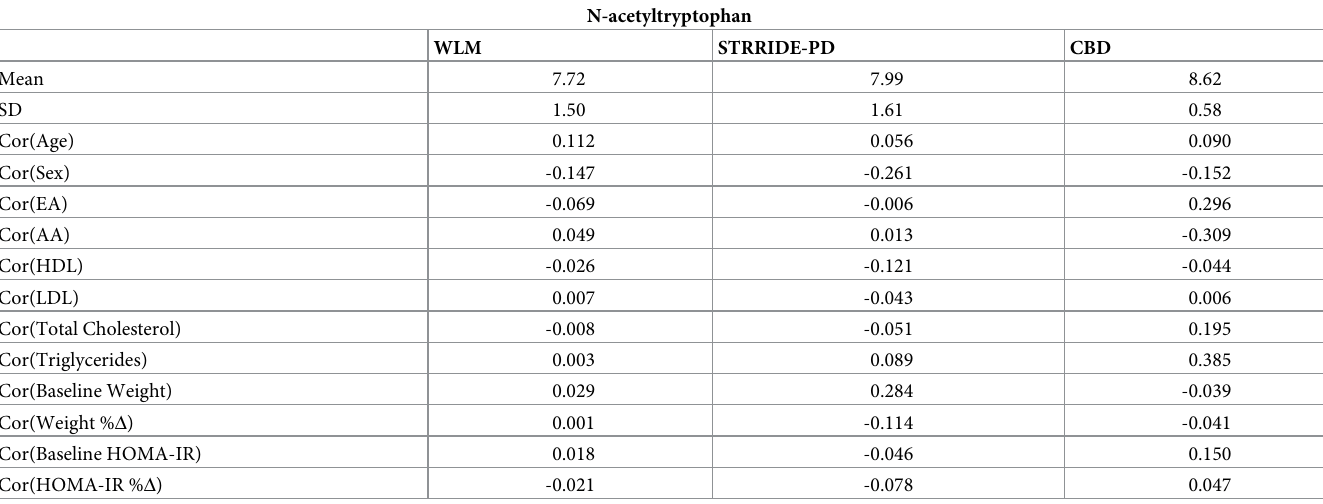
Table 5. Example metabolite and phenotype correlations for